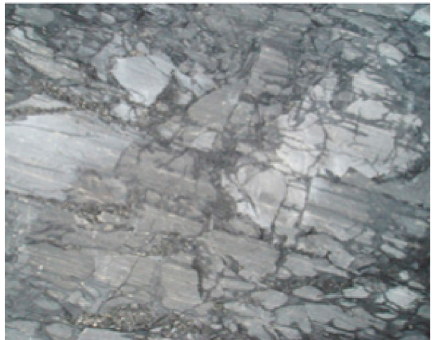
Figure 1: Schematic view of pre-existing defects in the natural rock mass